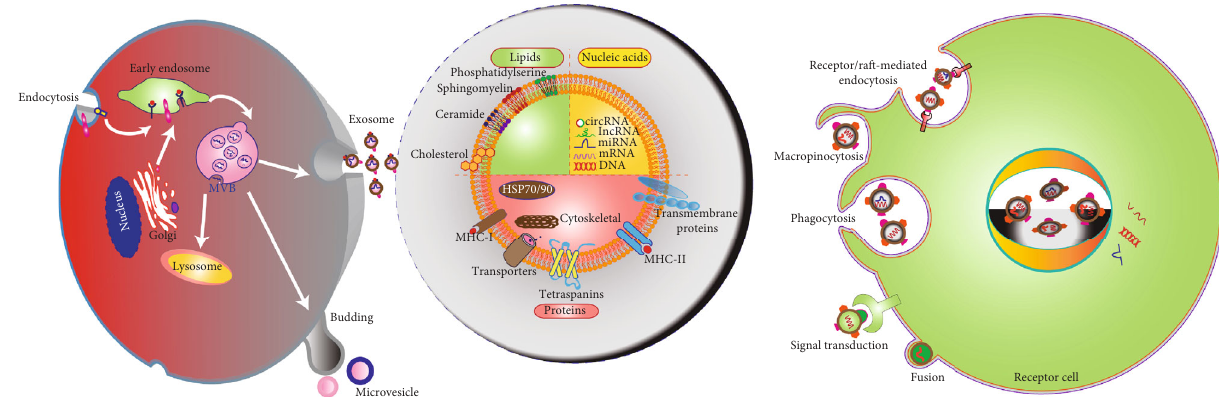
Figure 2: Schematic diagram of CDN biogenesis, structural composition, and cellular internalization. Exos are formed following plasma membrane invagination to form MVBs that are then exocytosed. The main components of CDNs are lipids, proteins, and nucleic acids. CDN lipids include cholesterol, ceramides, and phosphatidylserines, while CDN proteins include ubiquitous tetraspanins (CD9, CD63, and CD81) and HSPs. CDNs can (i) trigger cell signal transduction through intracellular signaling pathways and release of secretory contents; (ii) fuse with cell membranes, transfer proteins and genetic content, and enter the cytoplasm of recipient cells; and (iii) be endocytosed through phagocytosis, macropinocytosis, or receptor-mediated